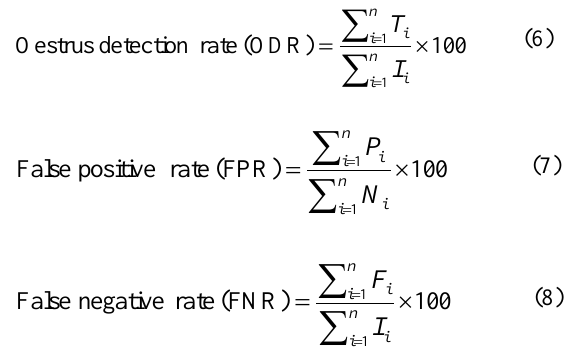
Figure 3. Spectrums of oestrus sound and normal sound,